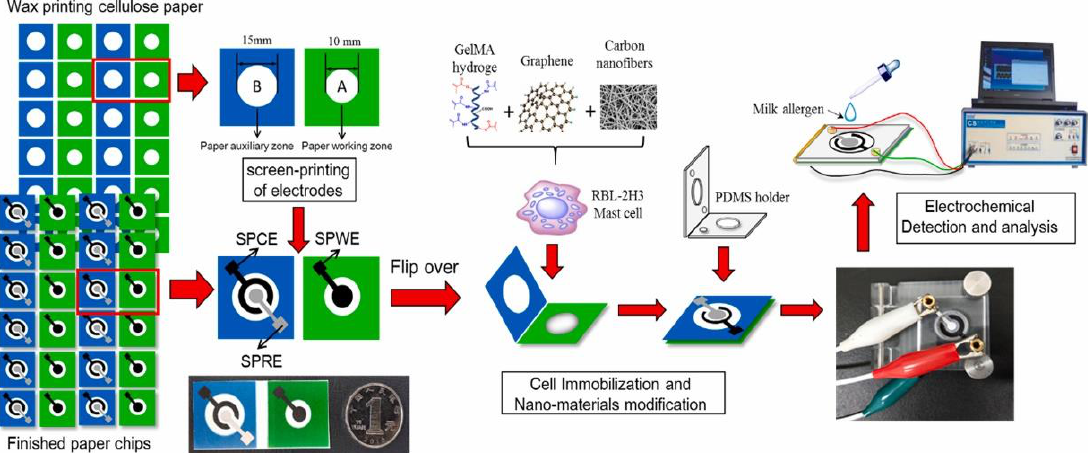
Figure 15. Scheme of the sensing platform assembly and assay procedure of casein detection. Reprinted with permission from [159]. Copyright 2019, Elsevier.